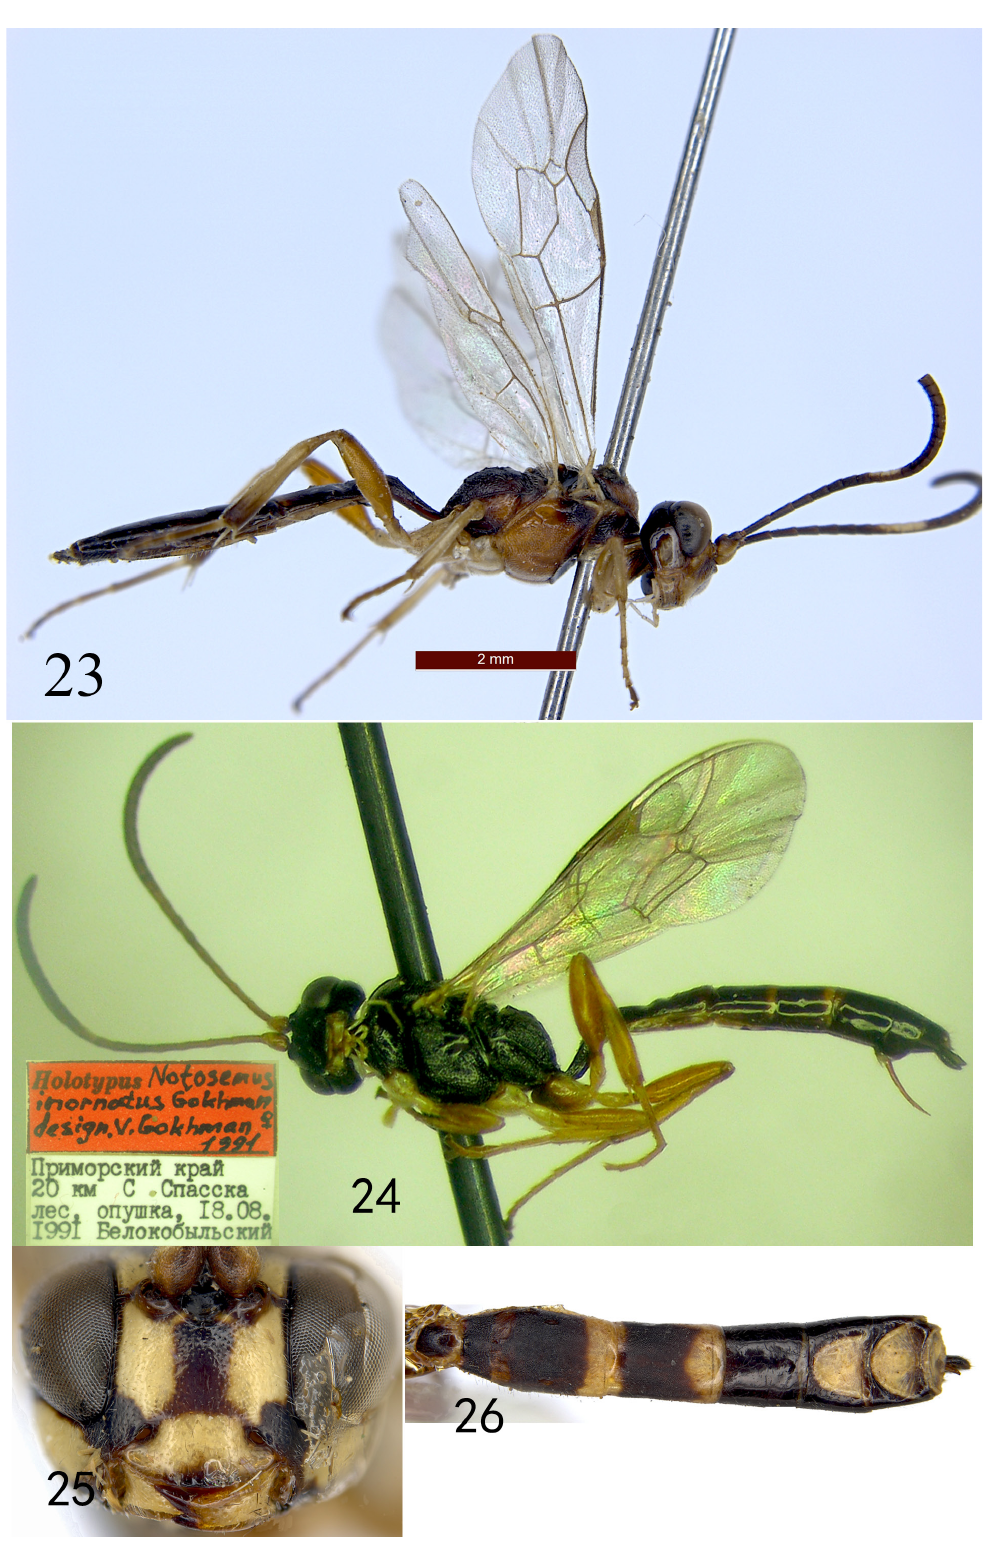
Figs 23–26. — 23 . Notosemus bohemani (Wesmael, 1855), ♀, habitus, lateral view. — 24 . Notosemus inornatus Gokhman, 1993, holotype, ♀, habitus, lateral view. — 25–26 . Notosemus variegatus (Tosquinet, 1903), holotype, ♀. 25 . head, anterior view. 26 . Metasoma,